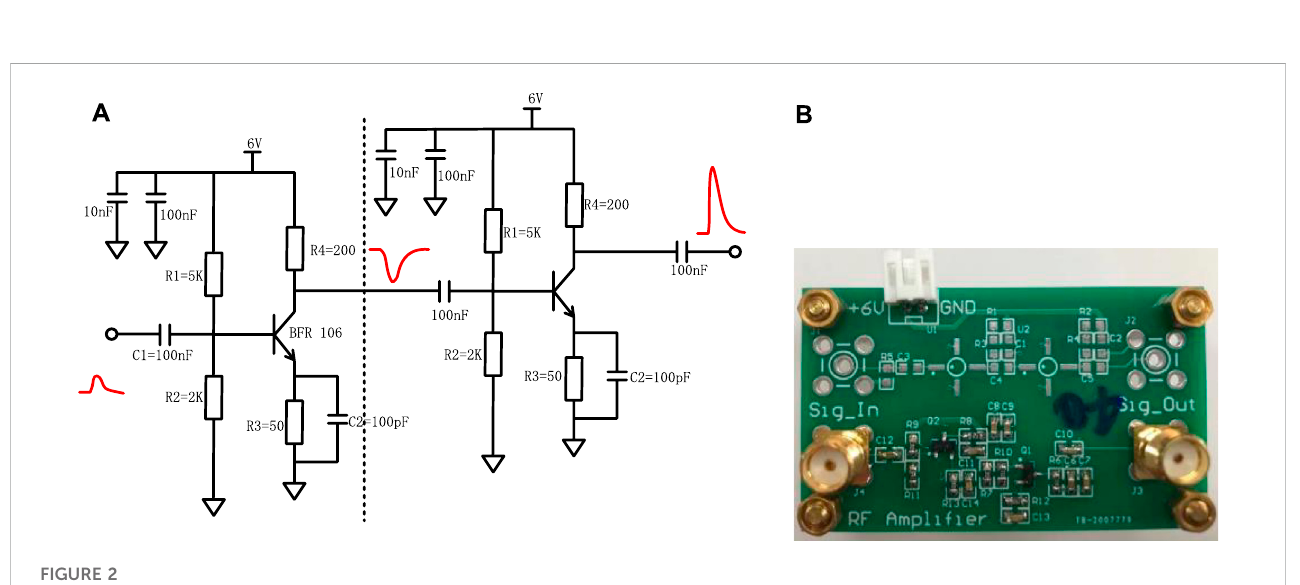
Schematic (A) and photograph (B) of two-stage common-emitter ampli fi cation